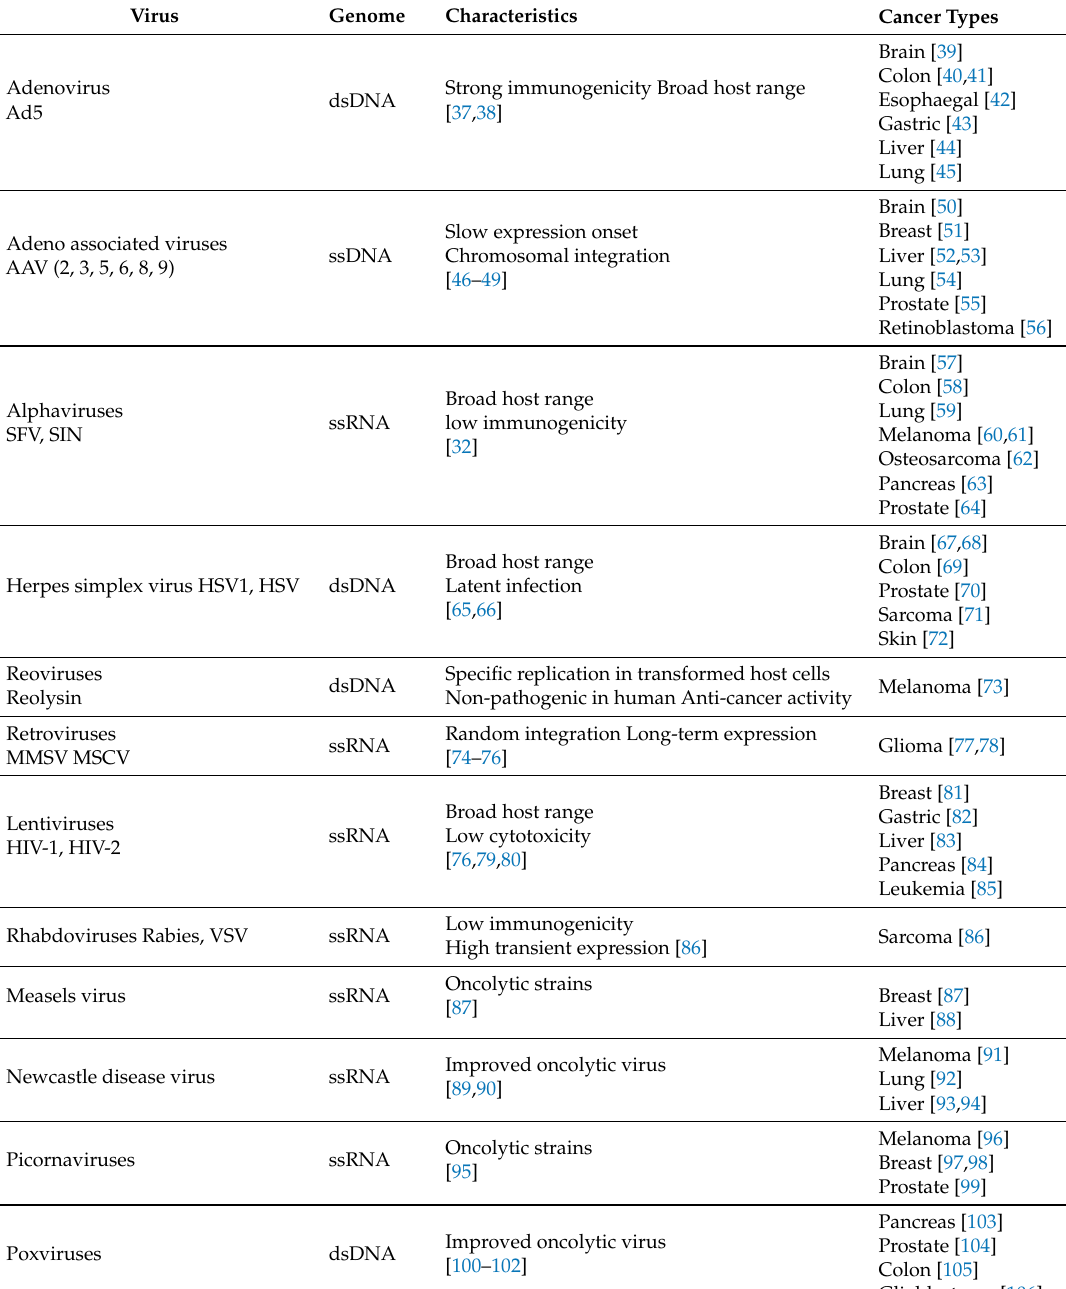
Table 1. Viruses and their vectors applied in overall gene therapy